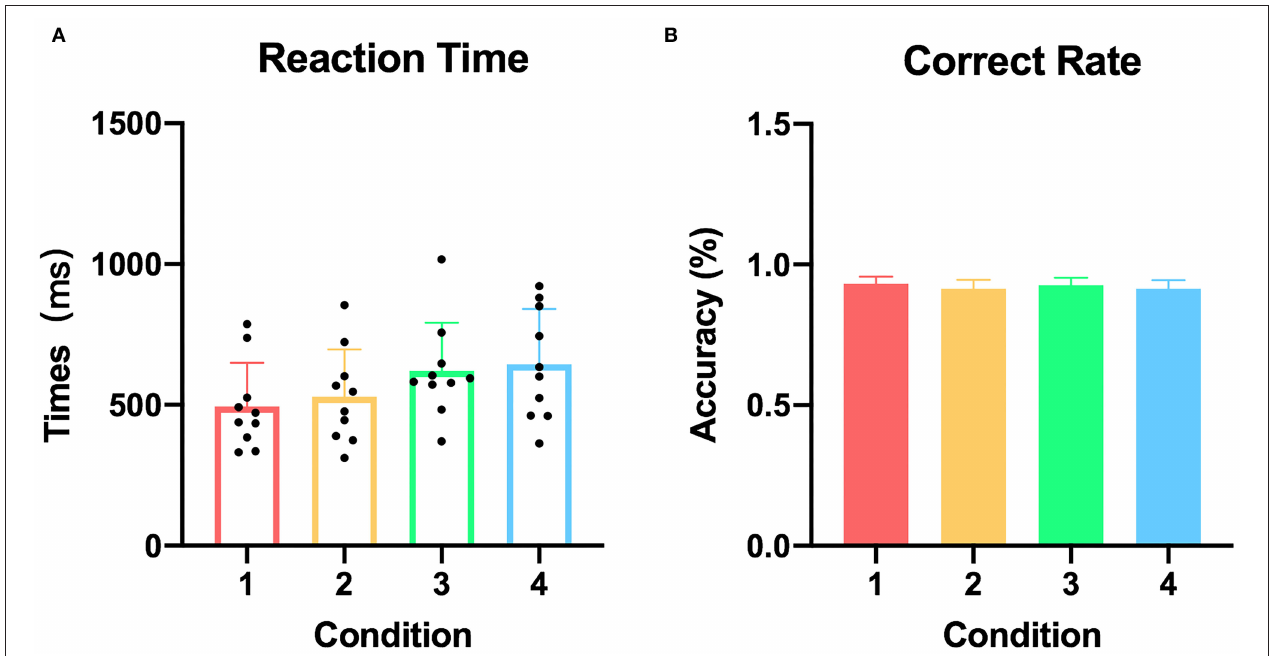
Frontiers in Human Neuroscience |